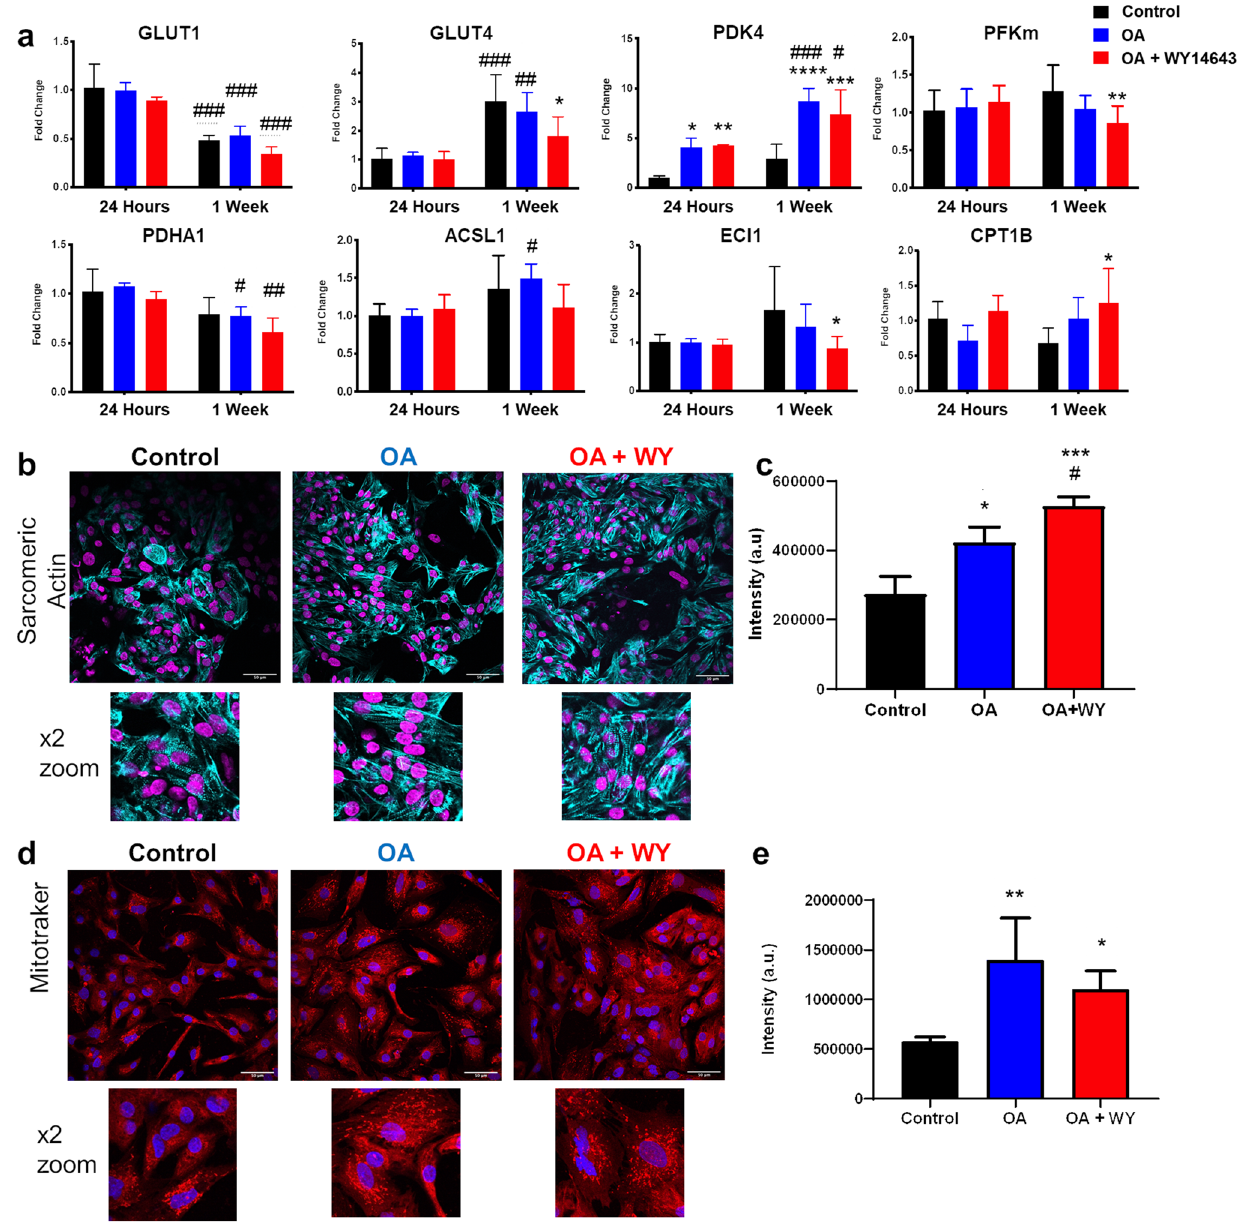
Figure 1. ( a ) Changes in mRNA gene expression of day 12 hiPSC-CMs seeded as a monolayer on RF-Matrigel and cultured for 24 h or 1 week with OA ± WY-14643; *,**,***,**** = p < 0.05, 0.01, 0.001, 0.0001 compared with control hiPSC-CMs cultured for 24 h; #,##,###,#### = p < 0.05, 0.01, 0.001, 0.0001 compared with control cells at the same time point (n = 4). Immunostaining for (b) α-Sarcomeric Actinin (cyan with DAPI in magenta) or (d) Mitotracker CMXRos (red with DAPI in blue) in day 12-15 hiPSC-CMs seeded as a monolayer on RF-Matrigel, as control or after treatment for 1 week with OA ± WY-14643; scale bar is 50 µM with × 2 zoom below; signal intensity is quantified in ( c , e ) *, ** p < 0.05, 0.01 compared with control hiPSC-CMs (n = hiPSC-CMs grown on scaffolds of collagen or collagen/C4S (Fig. 4f–i) but did increase glucose and palmitate oxidation in hiPSC-CMs grown on collagen/elastin scaffolds. In comparison to monolayers and scaffolds, cells in EHT have to contract against a restraining post (Fig. 5a) and are therefore doing more work, which has been shown to increase oxidative metabolism 32 . hiPSC-CMs grown in EHT showed higher sarcomeric actinin expression and clearer striations than cells cultured in 2D (Fig. 5b, c). Following treatment with OA ± WY-14643 for 1 week, changes in mRNA expression were investi- gated. Treatment with OA alone induced an increase in PDK4 , PGC1α , MYH6 and PPAR-α expression (Fig. 5d). There was an additional increase in PGC1α expression after treatment with OA + WY-14643, but levels of PDK4 and PPAR-α were comparable to those in control EHT cells. EHT had a significantly increased rate of FAO (both palmitate and oleate oxidation) and a substantial decrease in glycolysis compared to that of cells in the